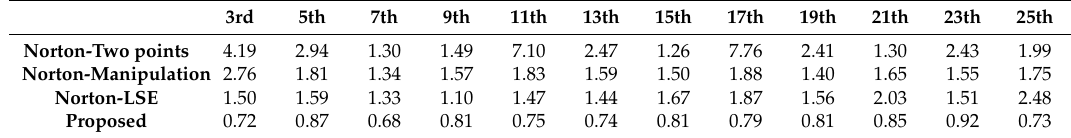
Table 6. Comparisons between the proposed method and Norton-based methods w.r.t. RMSE.